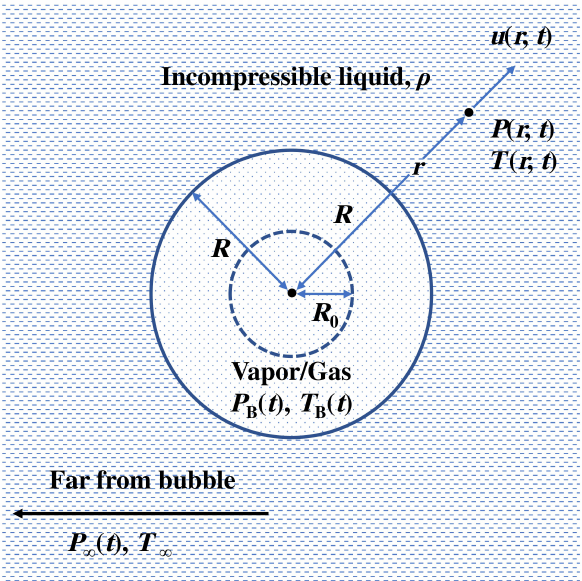
Figure 3. Schematic of a spherical bubble in the bulk of liquid. Parameters used to derive the RP equation are defined in the